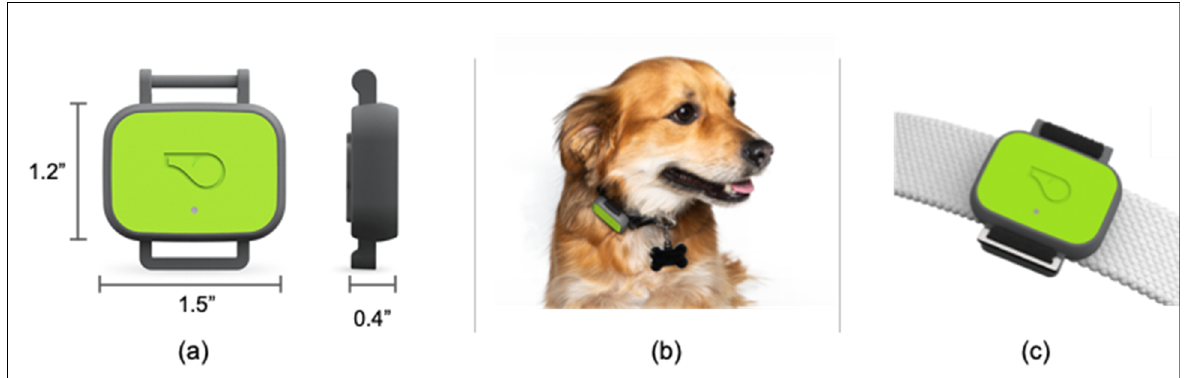
Figure 1. Activity monitors used in this study. Most data in this study were acquired from Whistle FIT ® activity monitors. Device dimensions are shown in ( a ), and a device in use is shown in ( b ). The device often rotates to different positions around each dog’s collar. The device can attach to most dog collars up to 1” (25 mm). Attachment detail is shown in ( c ). The two other devices used this study (the Whistle 3 ® and the Whistle GO ® ) are larger and heavier.